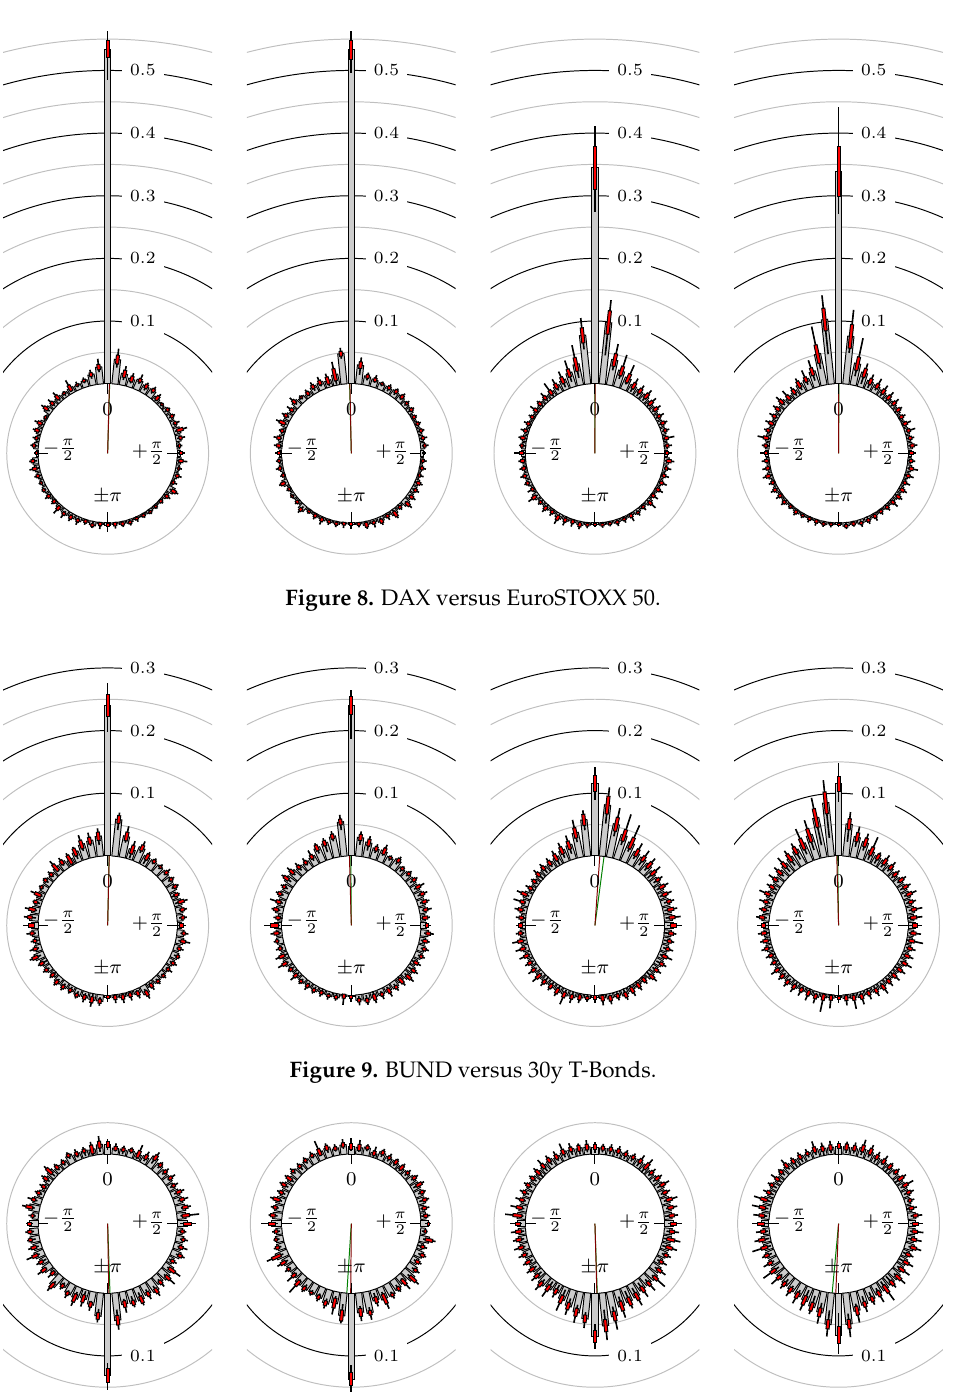
Figure 10. S&P 500 versus 30y